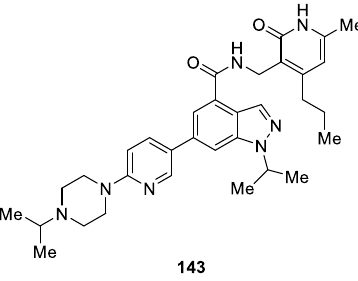
Figure 38. Chemical structure of 1 H -indazole derivative 143.